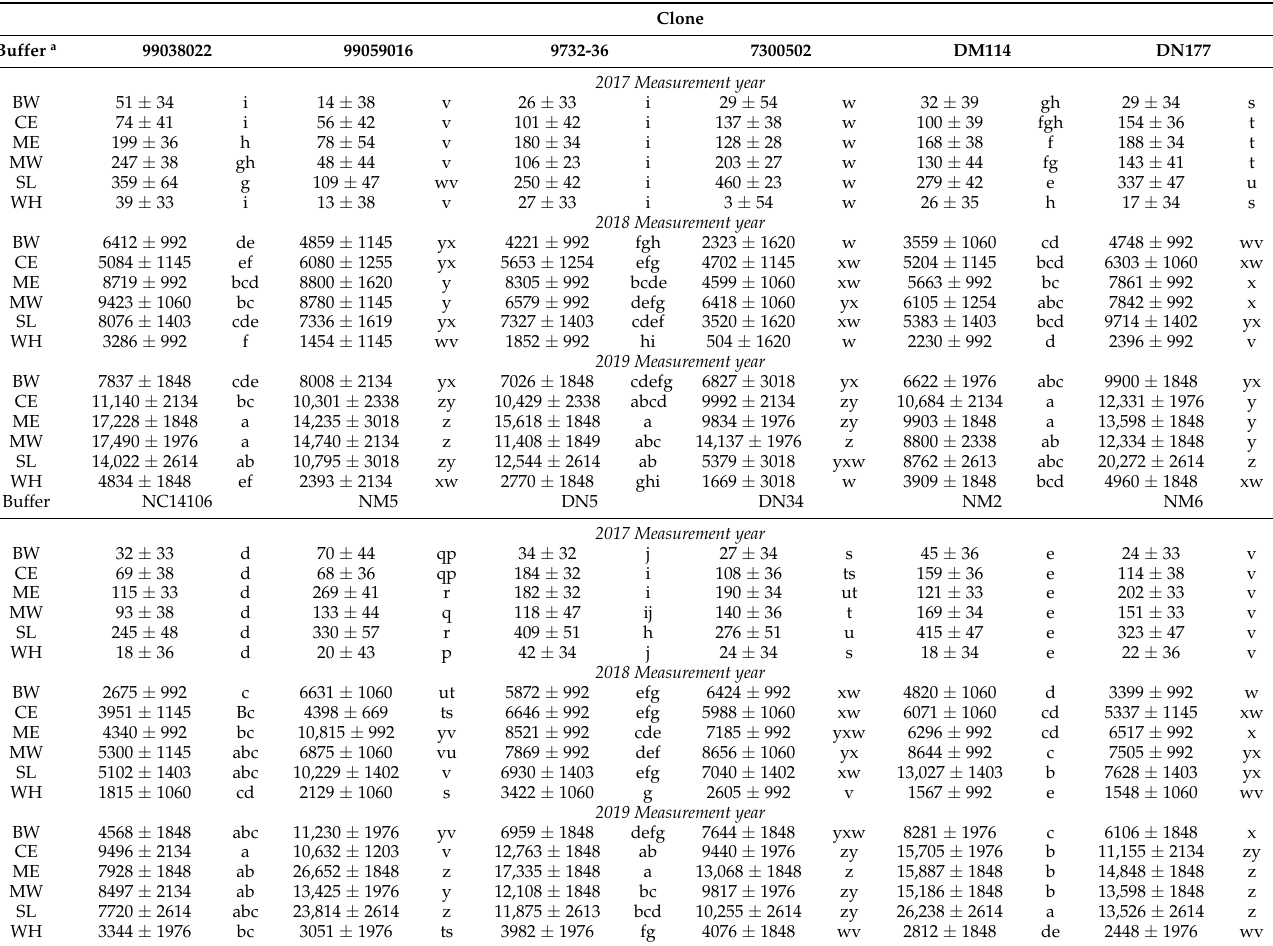
Table 5. Volume (cm 3 ) ( ± one standard error) of twelve poplar clones tested in six phytoremediation buffer systems (i.e., phyto buffers) established in 2017 (i.e., the 2017 buffer group) in the Lake Michigan watershed of eastern Wisconsin, USA. Trees were measured following the 2017, 2018, and 2019 growing seasons. Volume values with different letters within a clone column across measurement years are different at P <